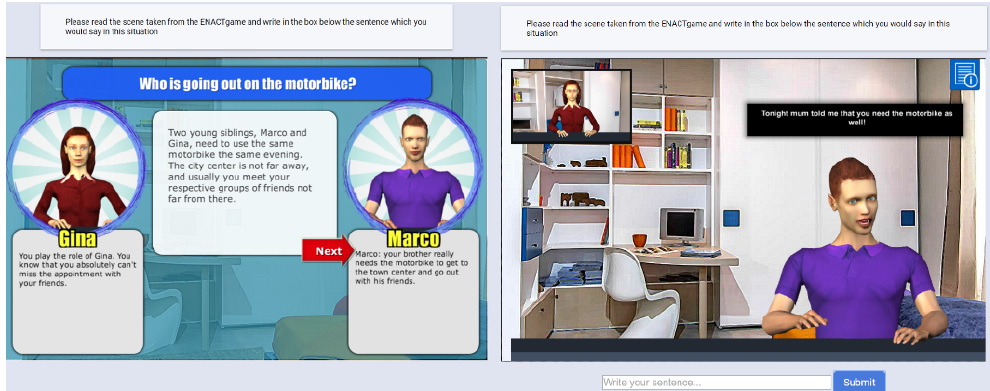
Figure 2. Sequence of the scenes in the natural language experiment. From the left, screenshot of the first introduction scene and screenshot of one interaction state of the first